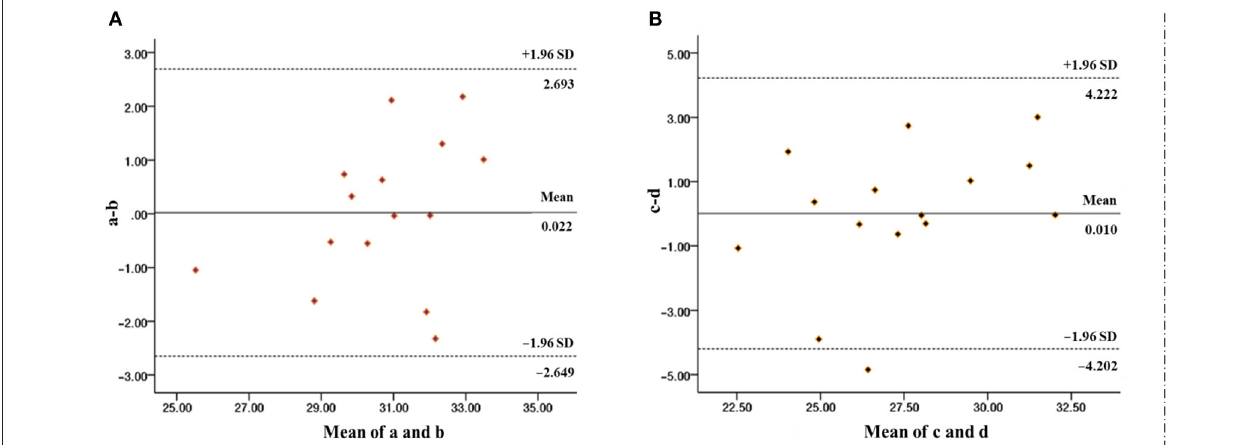
FIGURE 3 | Bland Altman diagrams of different methods for estimating the VO 2max of chemically synthesized drug addicts (A) and natural plant-derived drug addicts (B). Note: “a” in (A) represents the difference between the VO 2max measured by C PX and the VO 2max estimated by the years of drug use combined with the step index, and “b” means the mean value of the two. “c” in (B) represents the difference between the VO 2max measured by CPX and the VO 2max estimated by the step index, and “d” represents the mean value of the